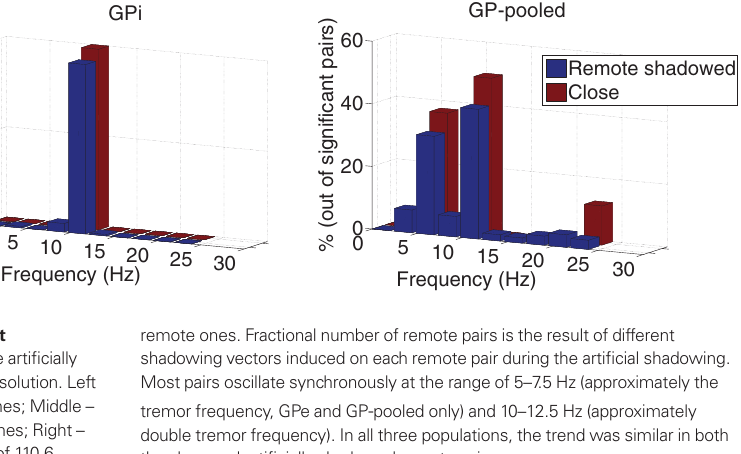
Figure 4 | Frequency distribution of the pairs with significant synchronous oscillations. The close pairs are compared with the artificially shadowed remote pairs; distributions are presented in a 2.5-Hz resolution. Left – GPe, based on five close pairs and an average of 32.2 remote ones; Middle – GPi – based on three close pairs and an average of 25.8 remote ones; Right – GP-pooled population, based on eight close pairs and an average of 110.6